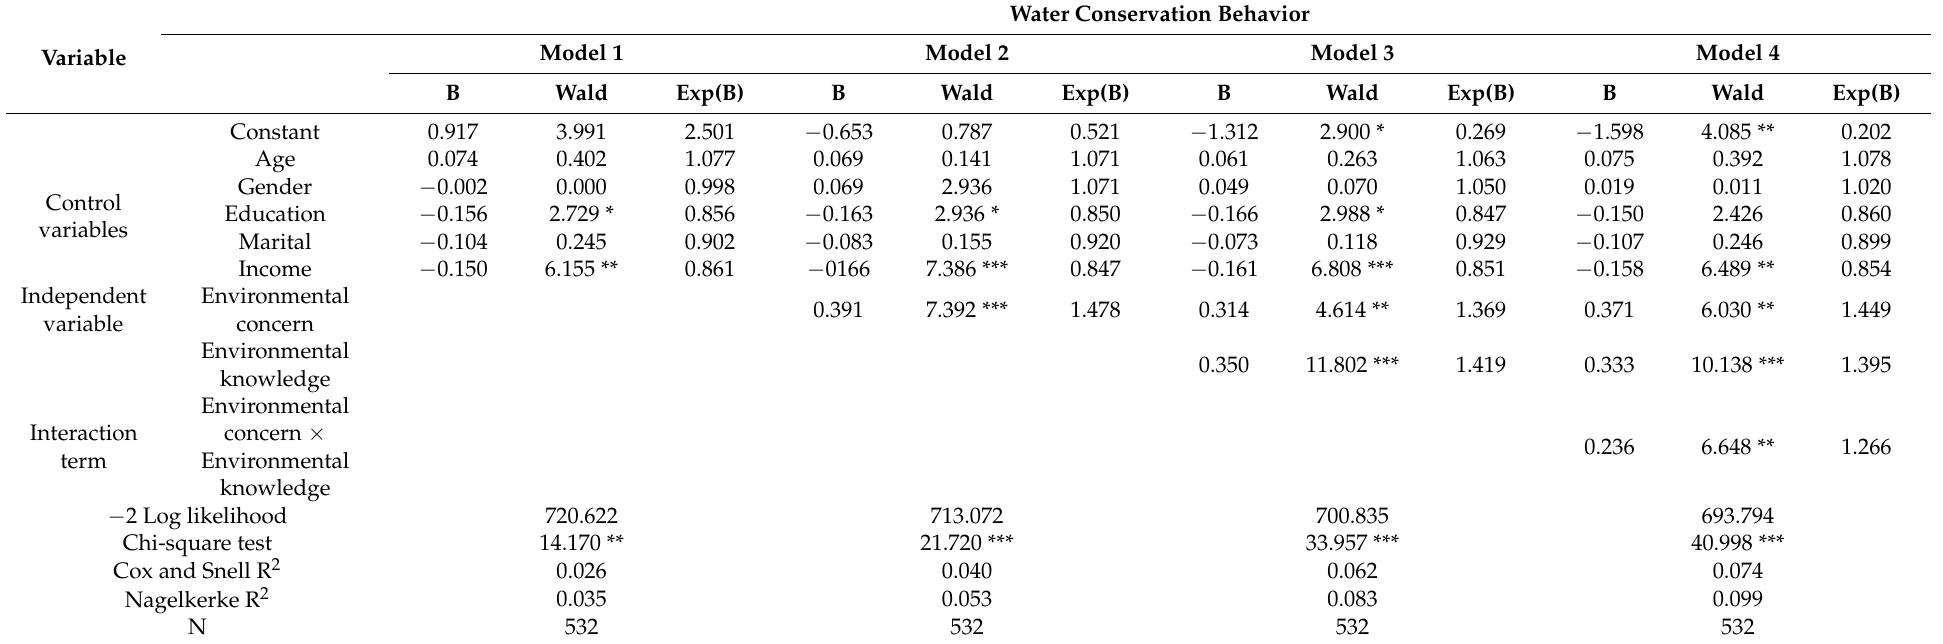
Table 2. Binary logistic regression results for water conservation